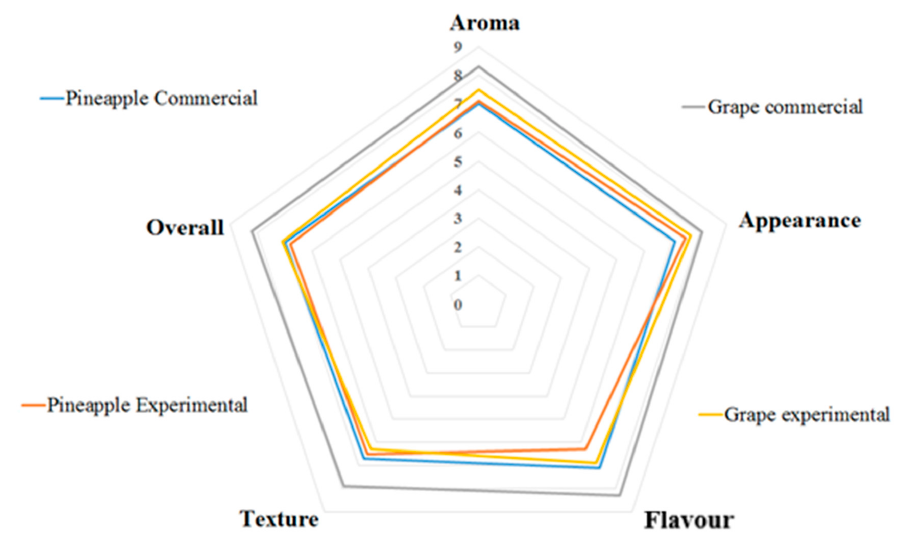
Figure 6. Response to sensorial qualities of gelatins.